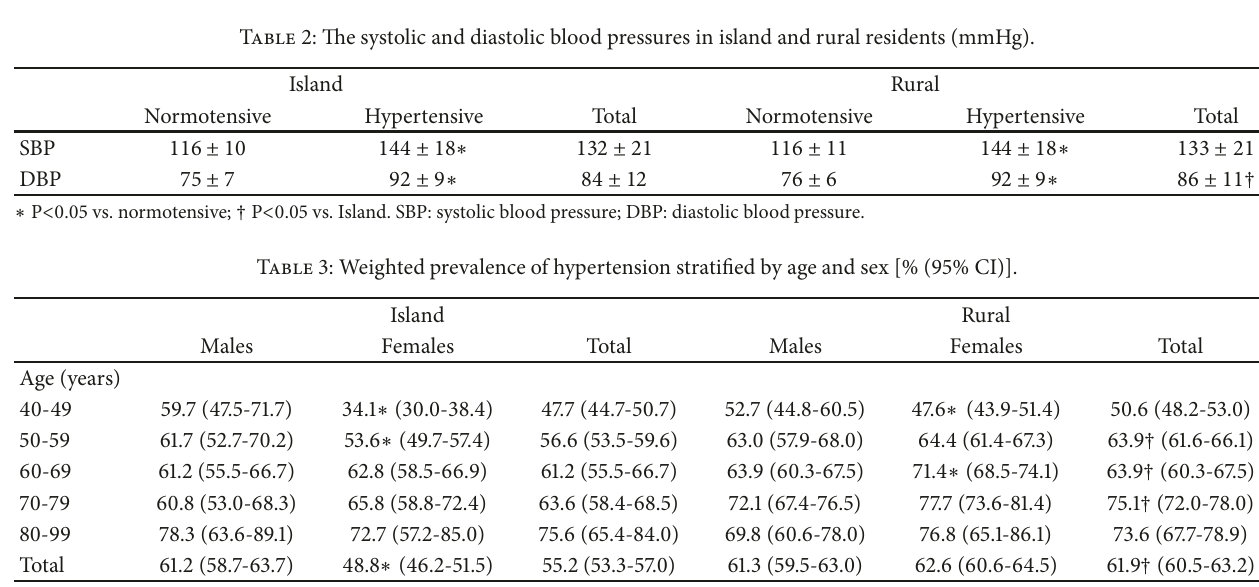
Table 2. SBP (144 ± 18 vs. 144 ± 18 mmHg, P > 0.05) and